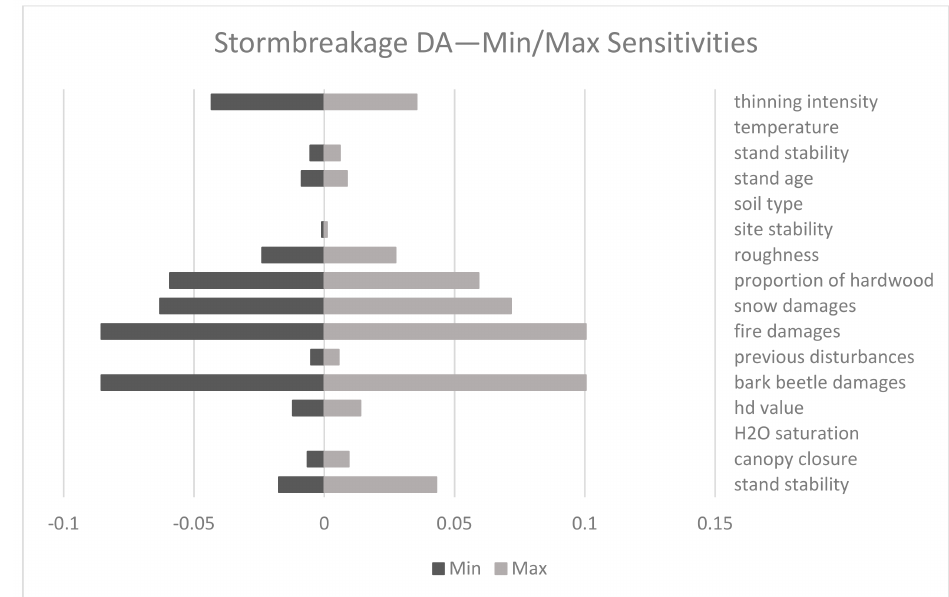
Figure 5. Sensitivities for the storm damage submodel. “Fire damages” and “bark beetle damages”